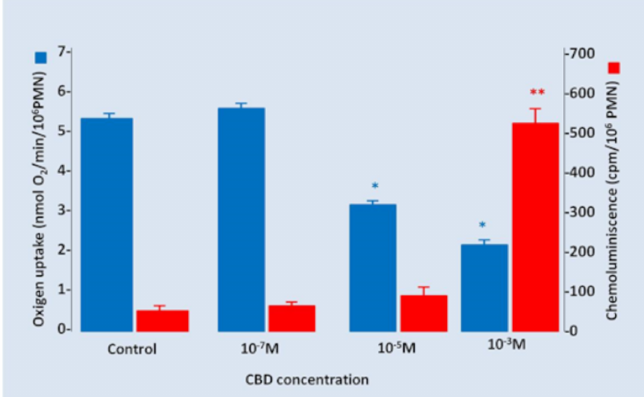
Figure 5. Oxygen uptake and chemiluminescence under several CBD concentrations. An inverse effect between oxygen uptake and chemiluminescence was observed secondary to the incubations of PMNs with increased concentrations of CBD. Results are expressed as mean ± SD ( p < 0.05). * and ** indicate the significance differences relative to 0 M of